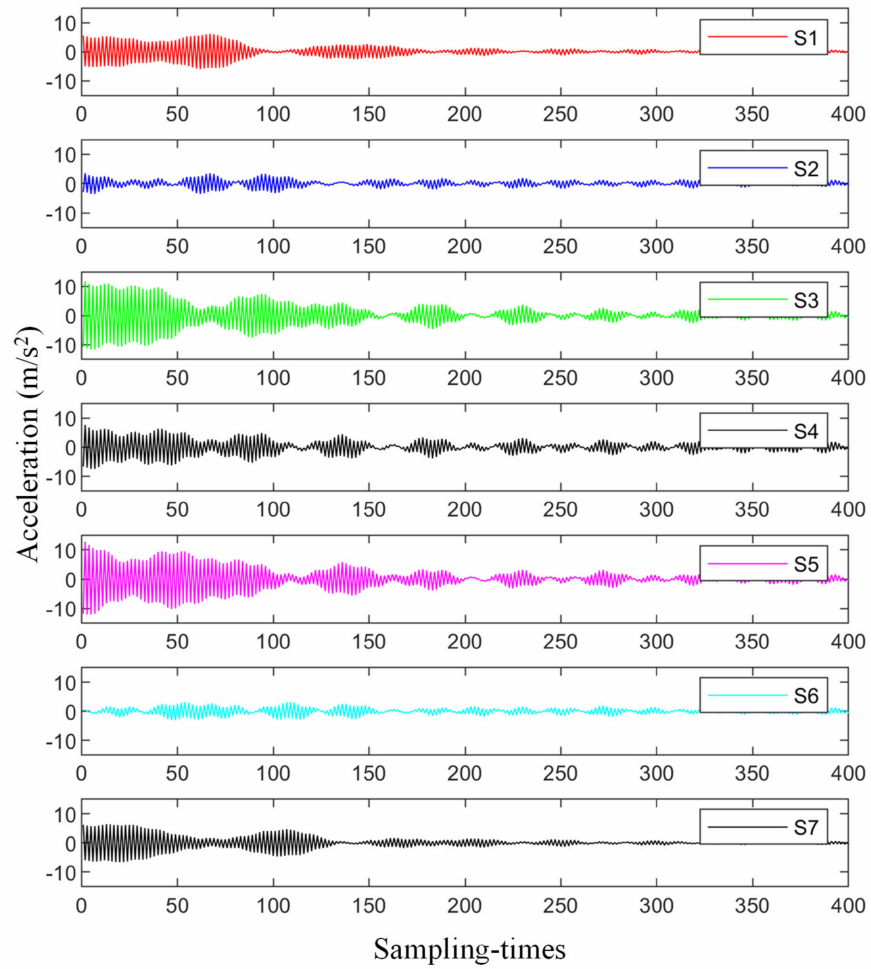
Figure A1. Acceleration signals from the numerical